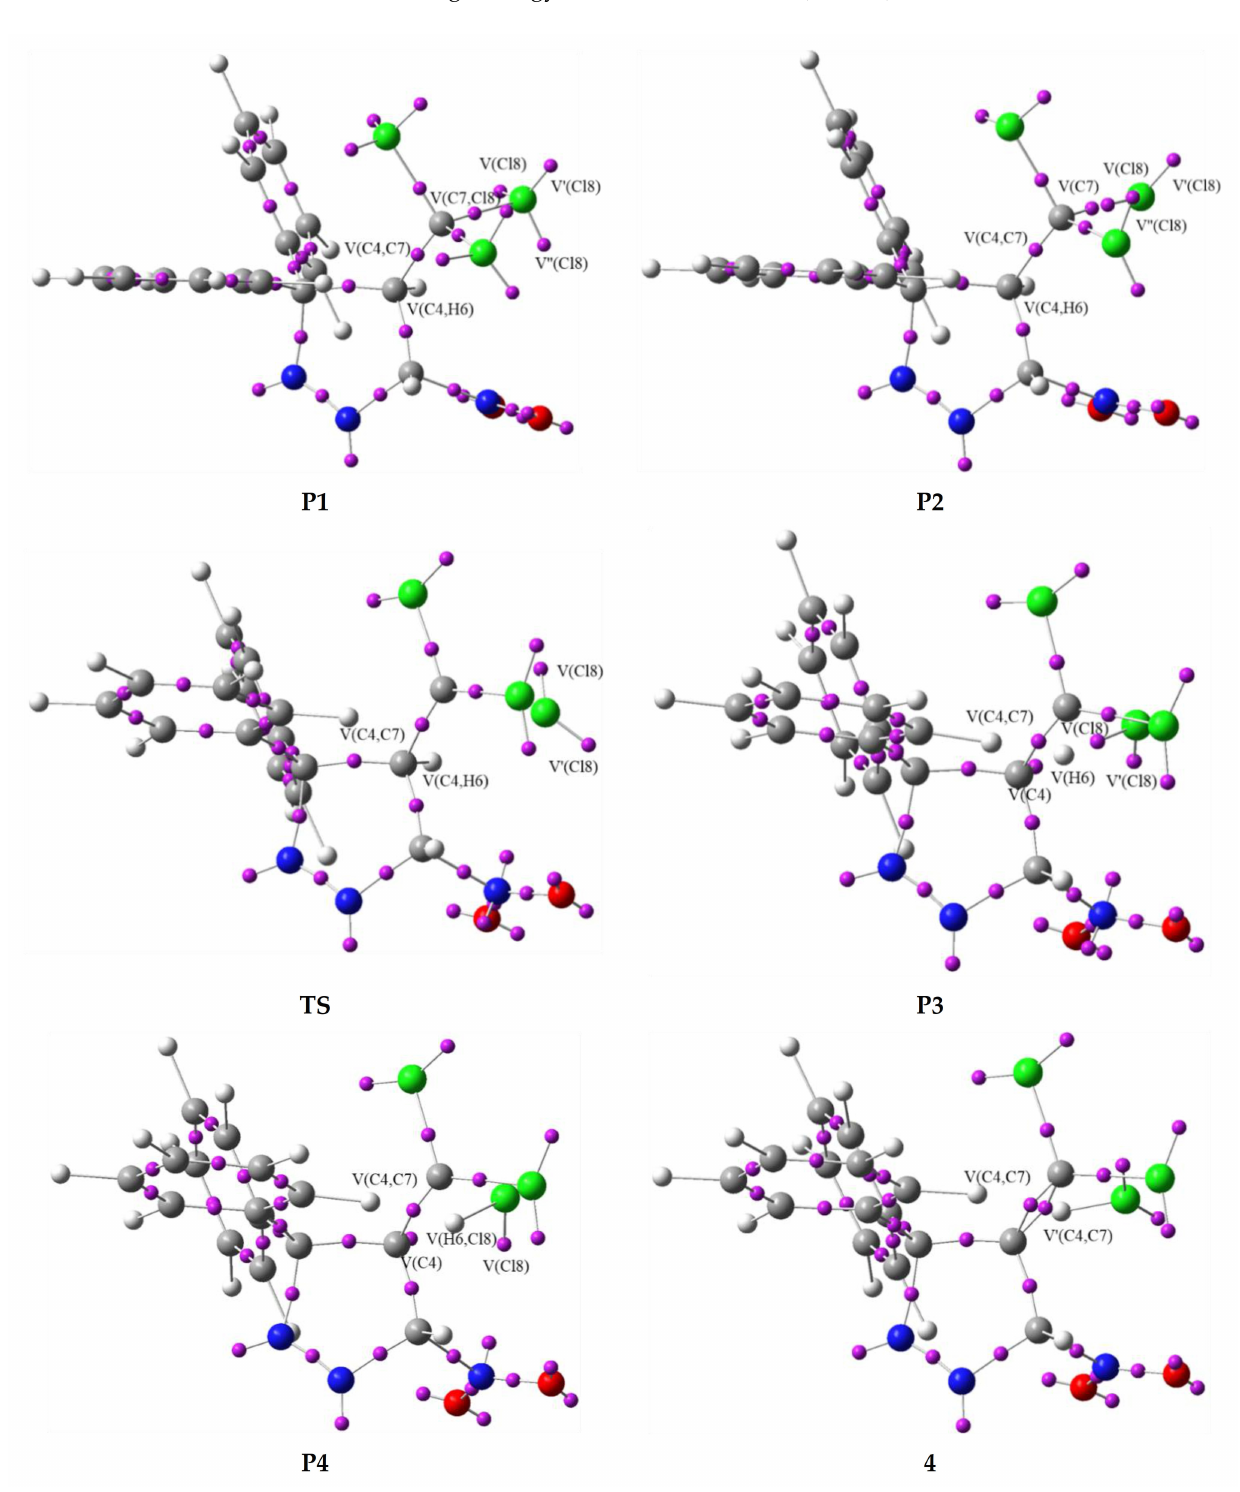
Figure 1. ELF atracttor positions for the points of the IRC defining Phases I-VI along the dehydrochlorination of 3 into 4 . At Phase IV , 2.78 Å ≤ d(C4-H6) < 2.99 Å, 2.65 Å ≥ d(C4-C7) > 2.63 Å, 6.05 Å ≥ d(C7- Cl8) > 6.04 Å, 3.13 Å ≥ d(H6-Cl8) > 2.91 Å, which starts at P3 , the next most